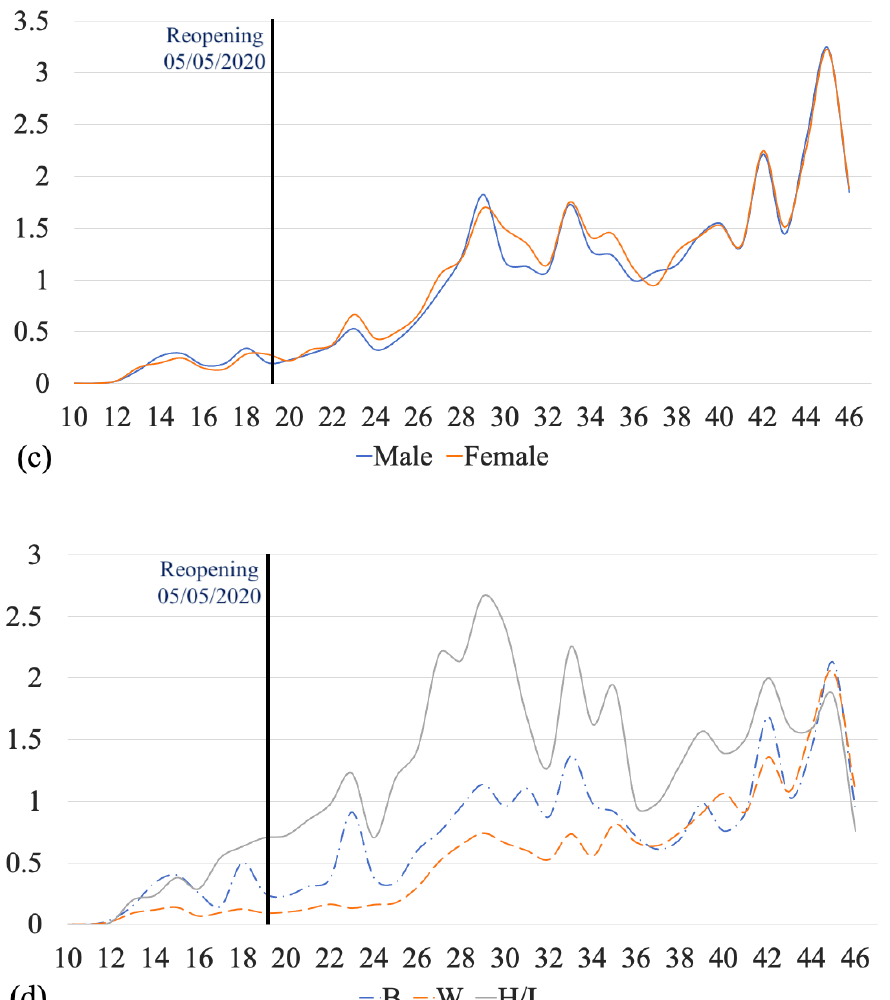
Figure 4. Time series of COVID-19 cases in Kansas City, MO, during March–November 2020. ( a ) Number of weekly new cases and mortality, ( b ) number of weekly new cases per thousand by county, ( c ) number of weekly new cases per thousand by gender, and ( d ) number of weekly new cases per thousand by race and ethnicity.